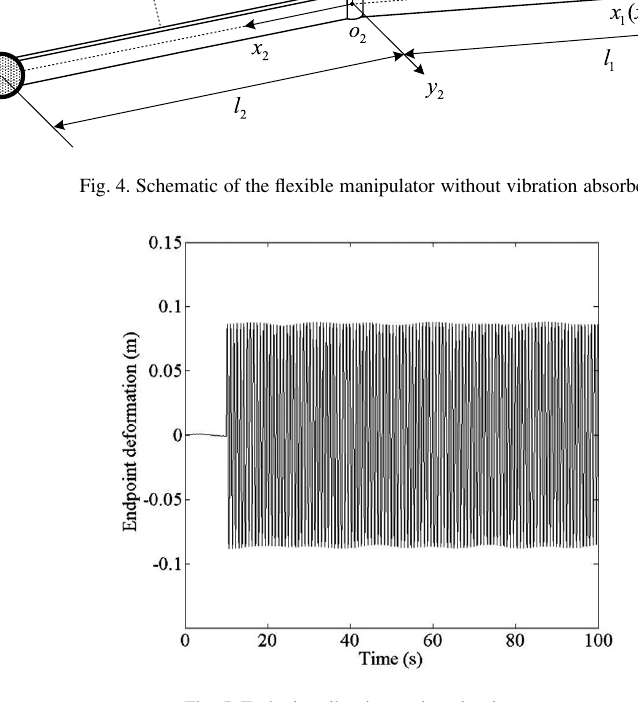
Fig. 5. Endpoint vibration undergoing impact.